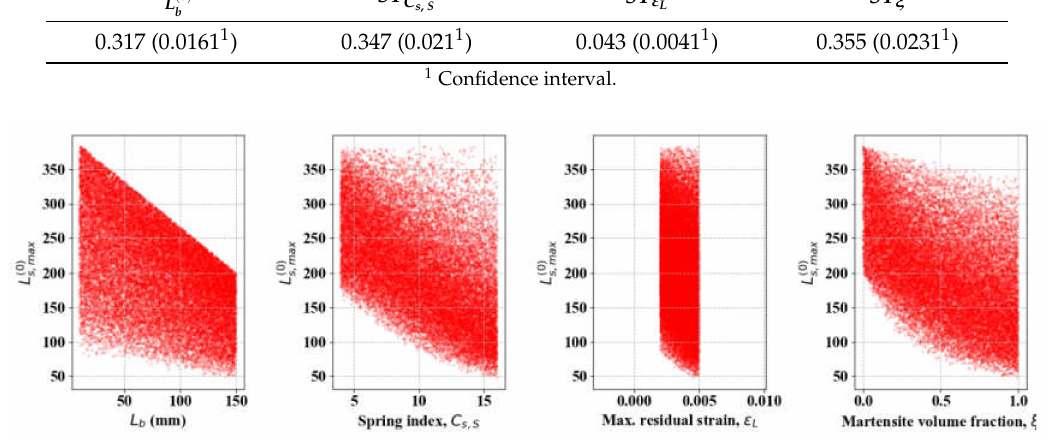
( 0 ) -related variables ( L = 300). S , max